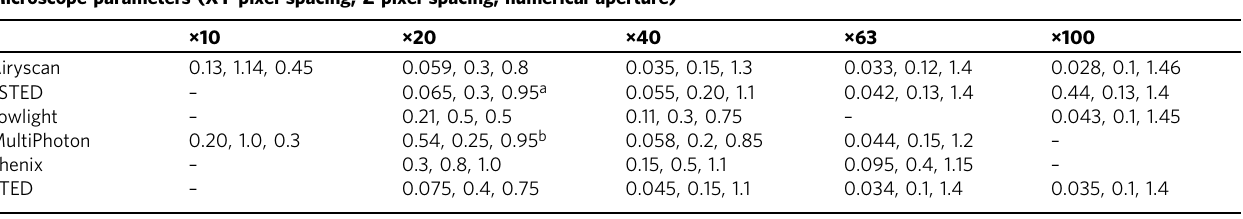
Table 1 Microscope parameters — the pixel spacing for XY and Z ( μ m) that the resultant PyFoci microscope image uses. Microscope parameters (XY pixel spacing, Z pixel spacing, numerical aperture)